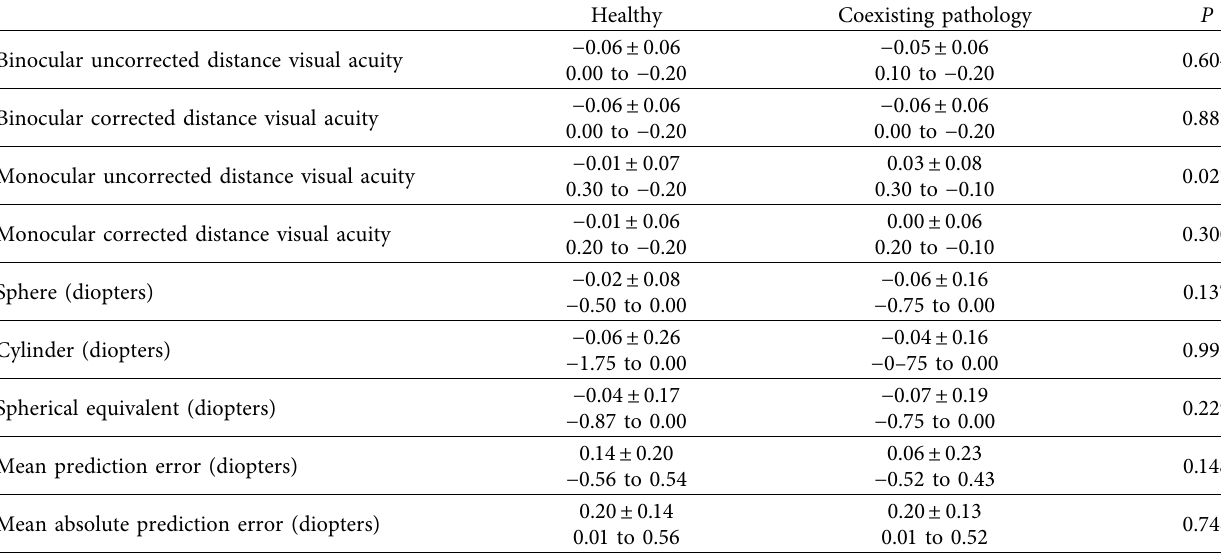
Table 2: Postoperative LogMAR distance visual acuity, refractive status, and prediction error. Values provided are mean (standard deviation) and range. P value is from the Kruskall-Wallis